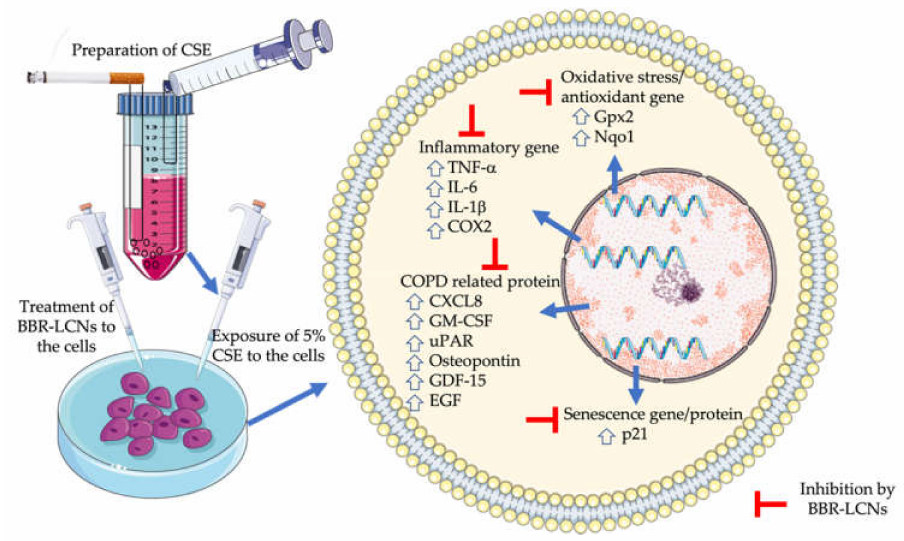
Figure 9. Antioxidative, anti-inflammatory, and antisenescence activity of BBR